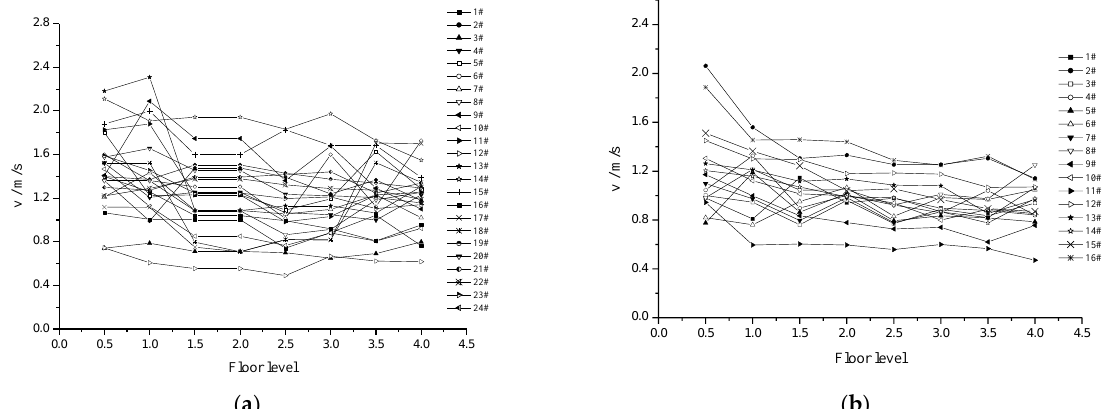
Figure 7. Ascending speed distributions of each participant in Group A along the climbing level (traveling over 4 floors). ( a ) Male; ( b ) female.